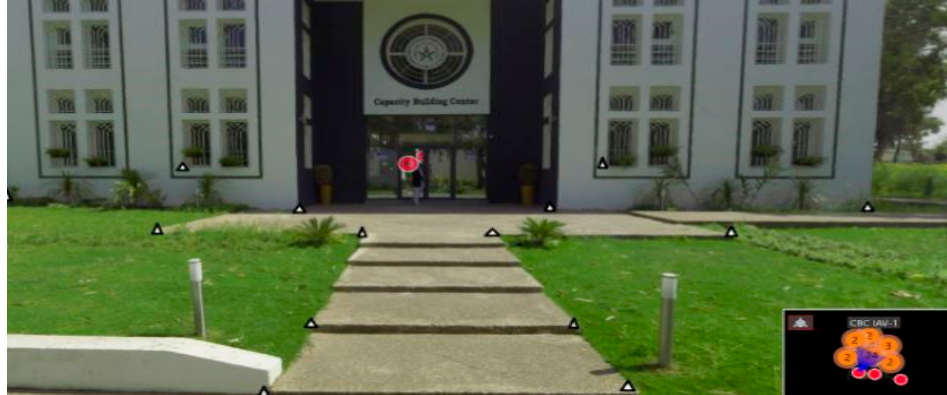
Figure 10. Distribution of markers outdoors.